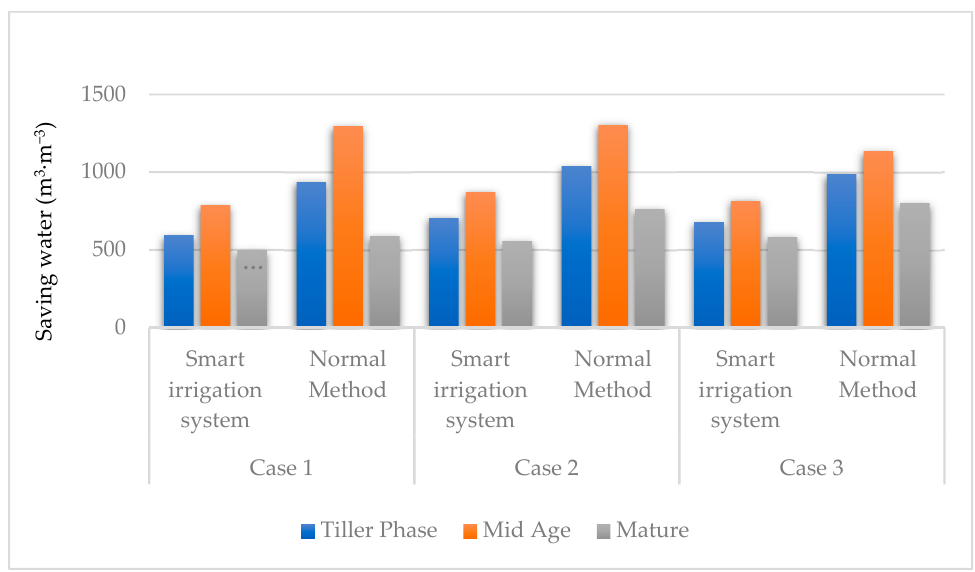
Figure 11. Sensor data with variation.